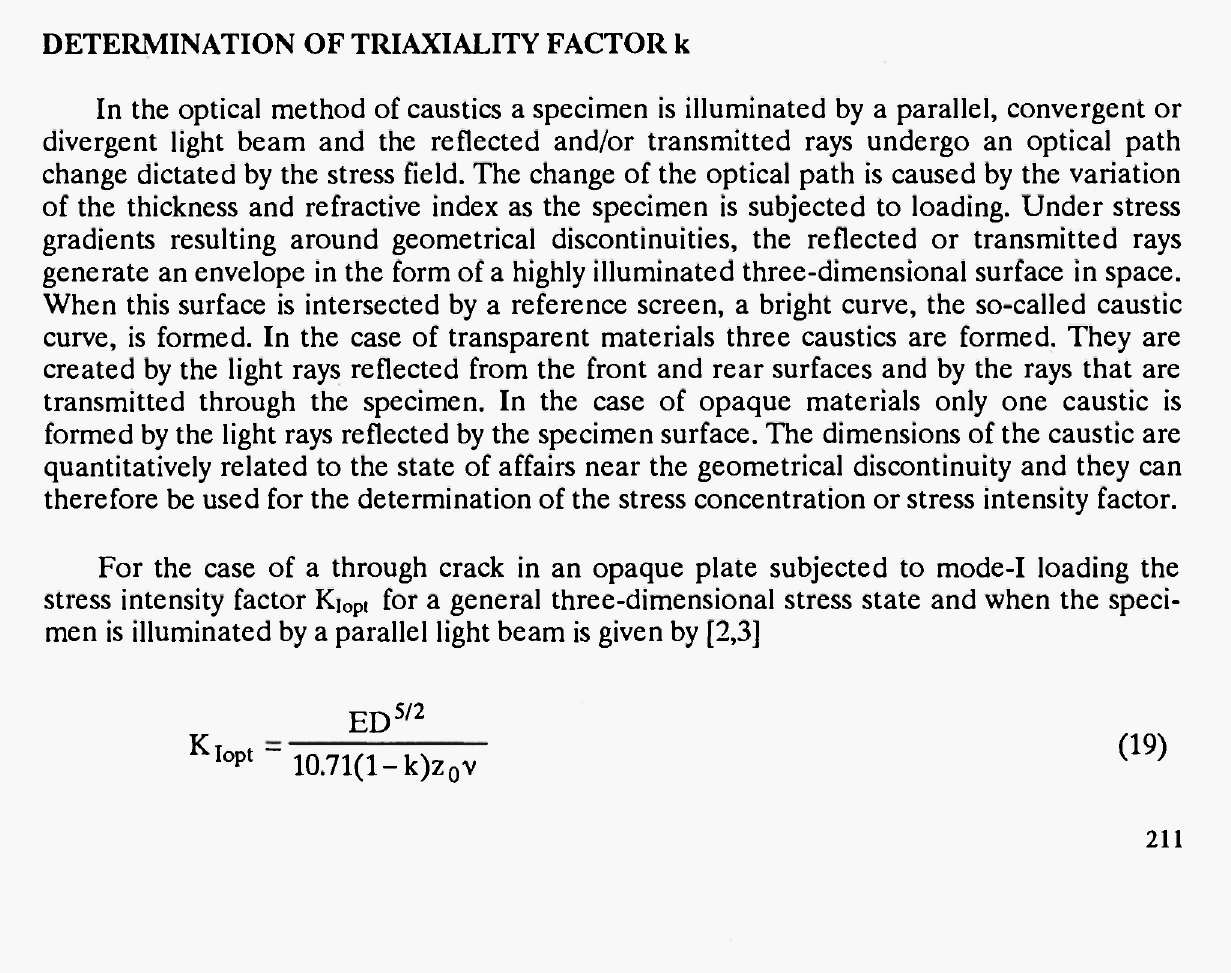
Figure 2 Optical